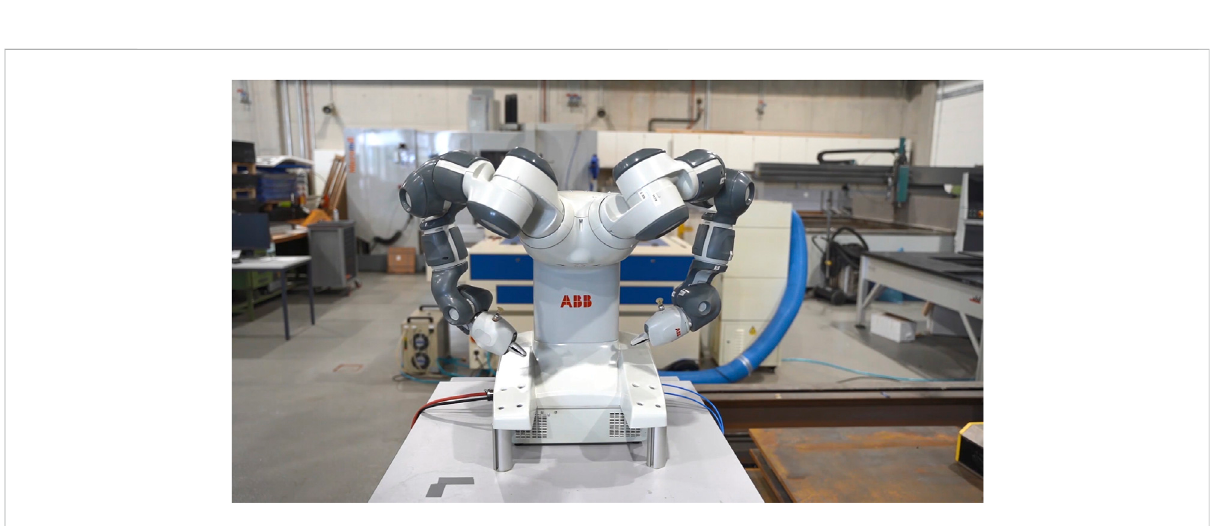
FIGURE 2 The crossing arm gesture as illustrated in the stimulus